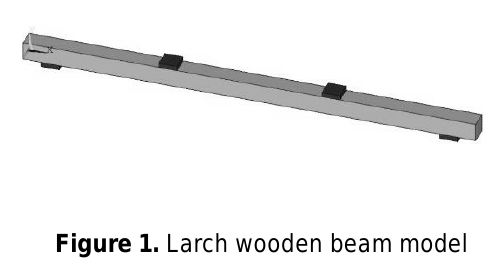
Figure 1. Larch wooden beam model